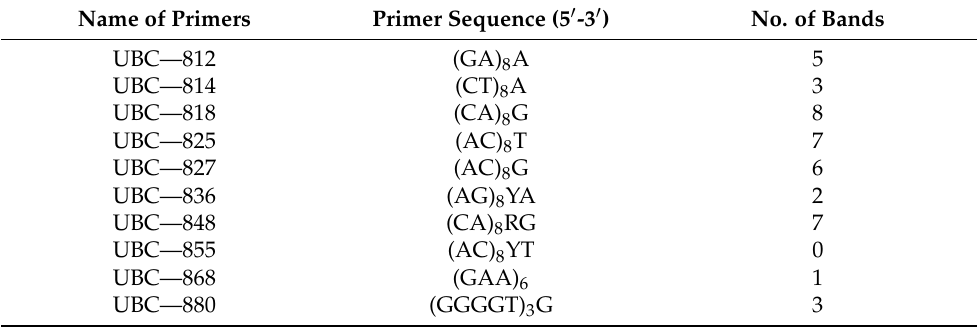
Figure 3. Amplified-DNA profile of the mother plant (Lane M) and in vitro plants of D. palmatus (Lane 1-9) obtained through RAPD primer (OPL-8; panel ( a )) and ISSR primer (UBC-818; panel ( b )) showing the monomorphic banding pattern. L—DNA ladder. Table 5. Amplified-DNA bands generated from inter simple sequence repeat primers in the mother plant and in vitro-propagated plants of D. palmatus